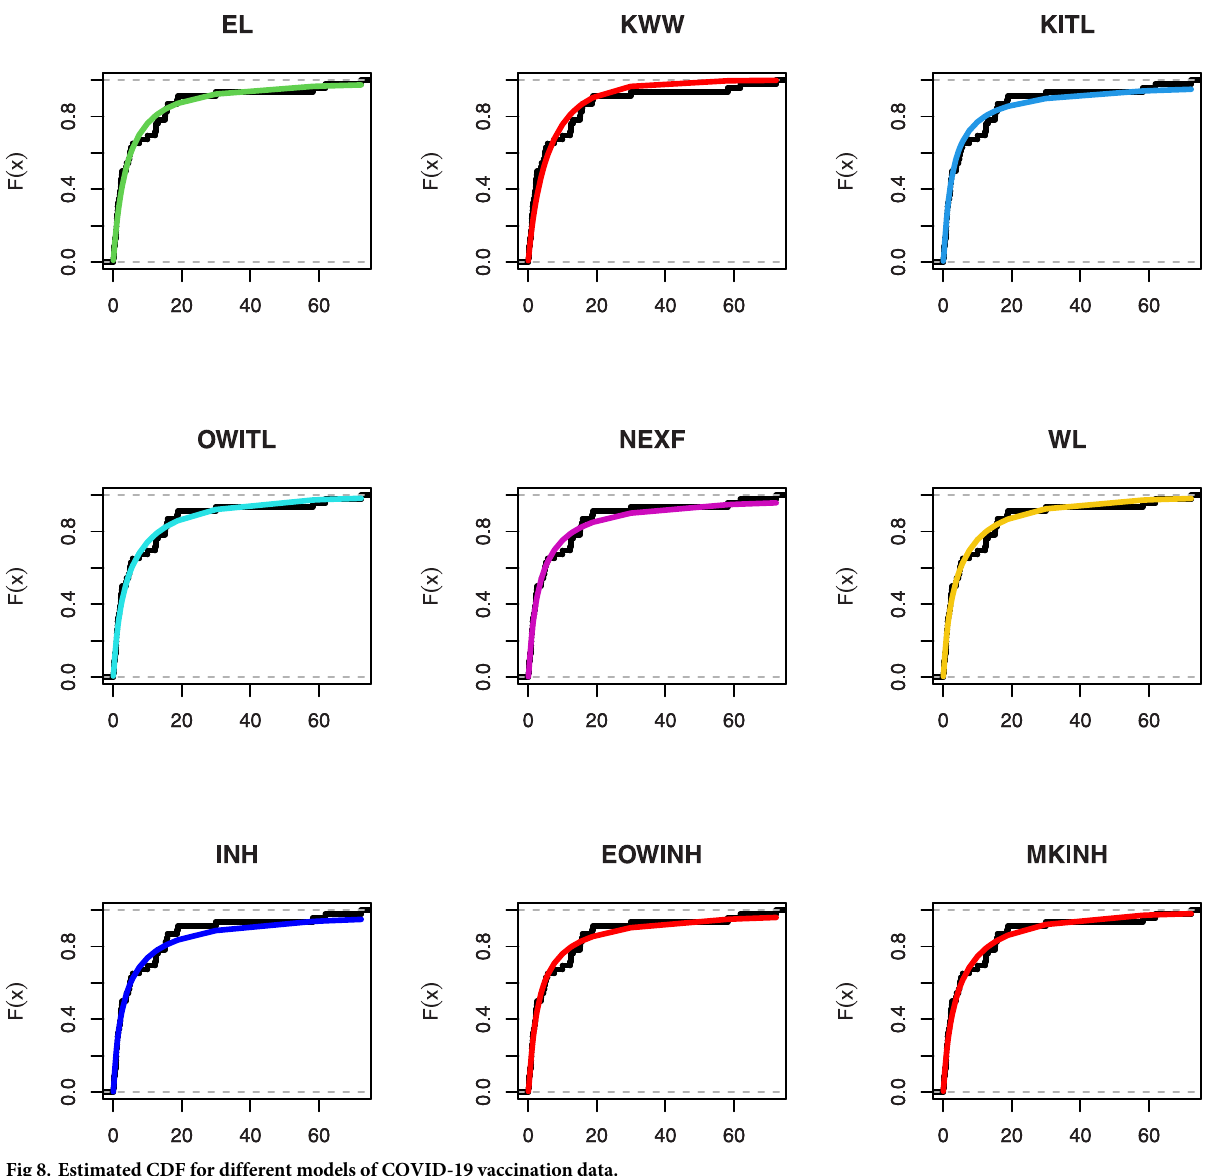
Fig 8. Estimated CDF for different models of COVID-19 vaccination data.